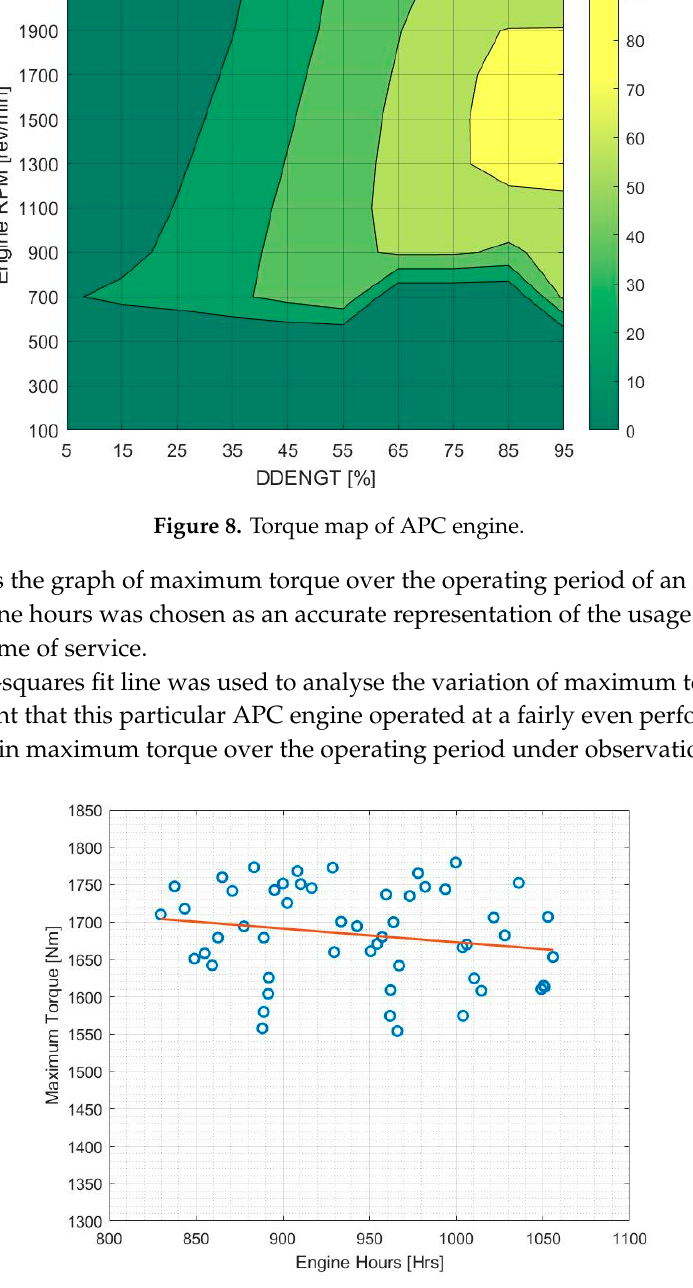
Figure 9. Maximum torque variation with engine hours.